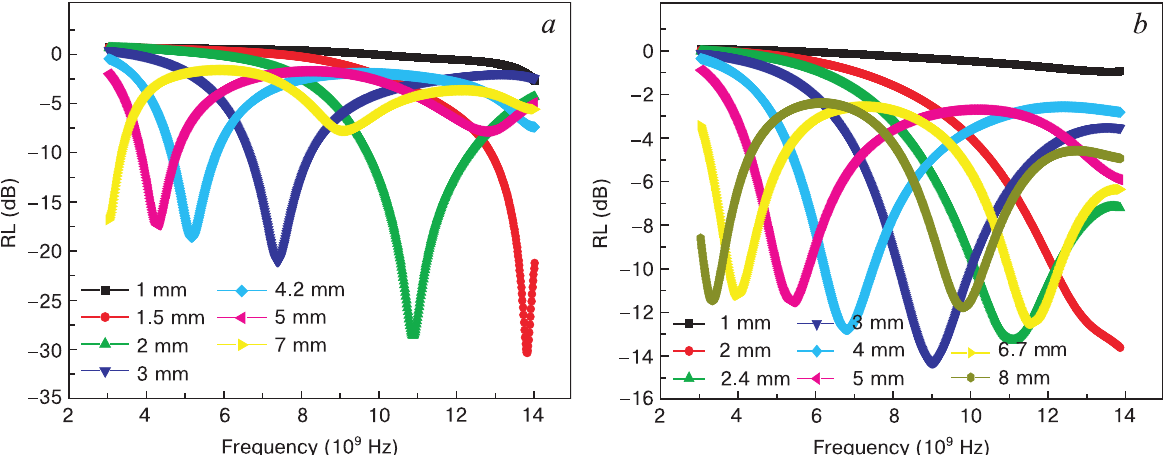
Figure 9. Frequency dependences of reflection coefficient of nanocomposites for different metal content ratios in precursor Fe : Co : Al: ( a ) 40 : 40 : 20; ( b ) 35 : 35 : 30.